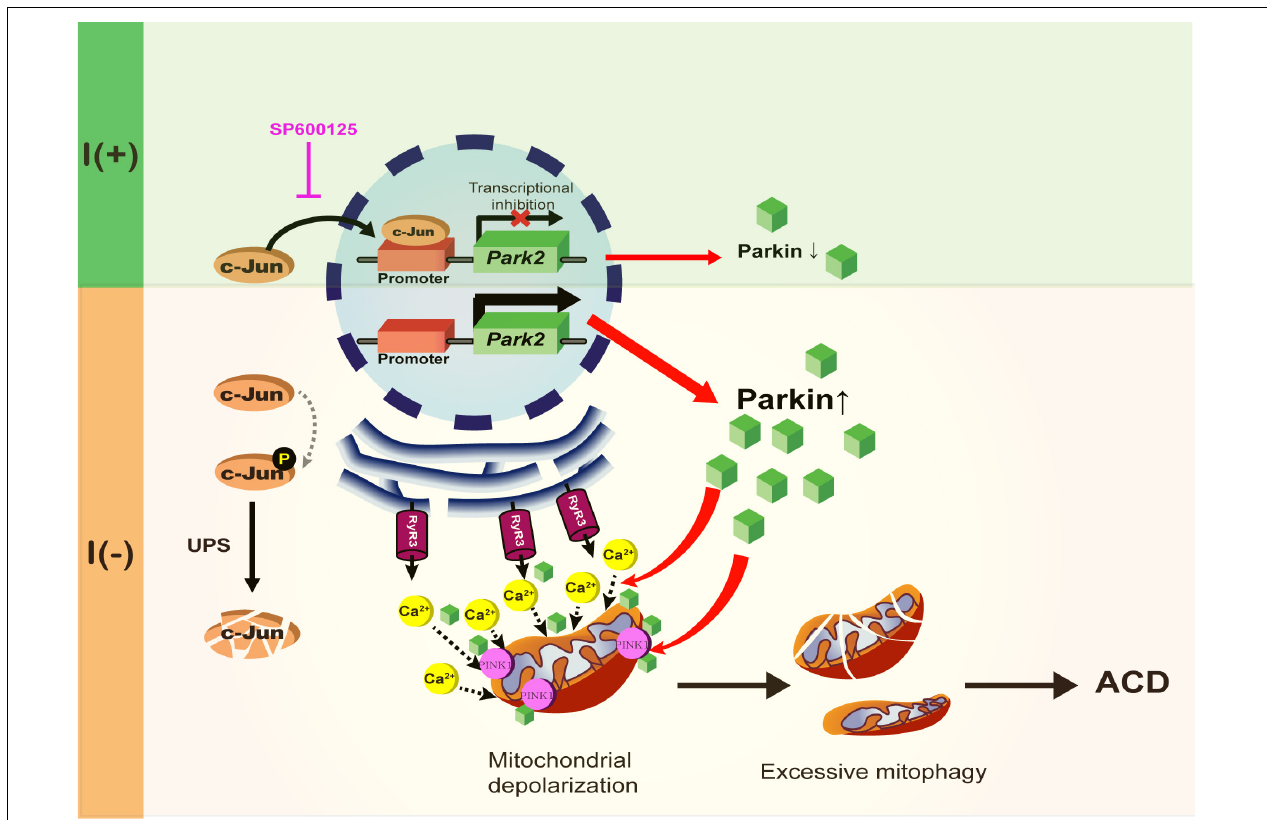
FIGURE 9 | A schematic diagram of Parkin-dependent mitophagy and ADCD. Parkin expression is increased by the degradation of c-Jun, a transcriptional repressor of Parkin in insulin-deprived HCN cells. Insulin withdrawal induced mitochondrial depolarization and recruitment of Parkin and PINK1 to mitochondria, where Parkin is also required for ER-to-mitochondria Ca 2 + transfer. PINK1/Parkin-dependent mitophagy occurs in HCN cells following insulin withdrawal causing excessive mitophagy and